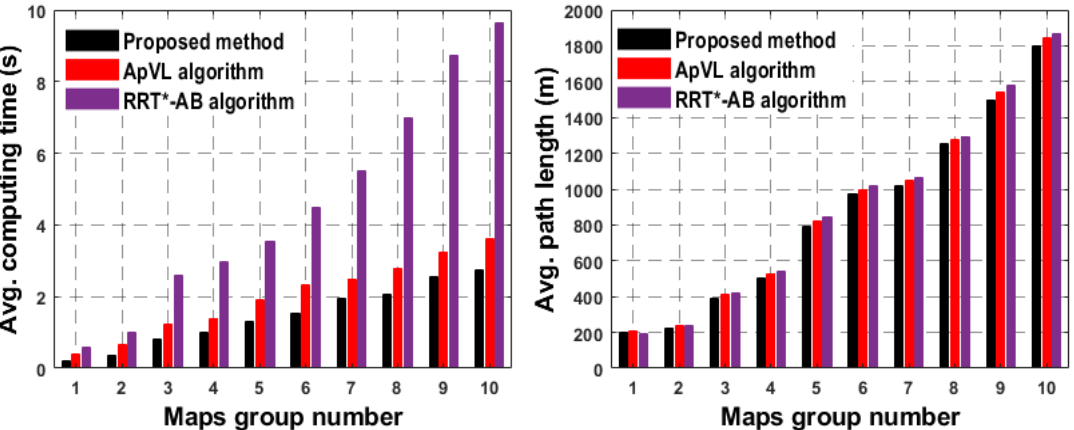
Figure 9. ( Left ) computing time: proposed method versus existing algorithms; ( Right ) path lengths: proposed method versus existing